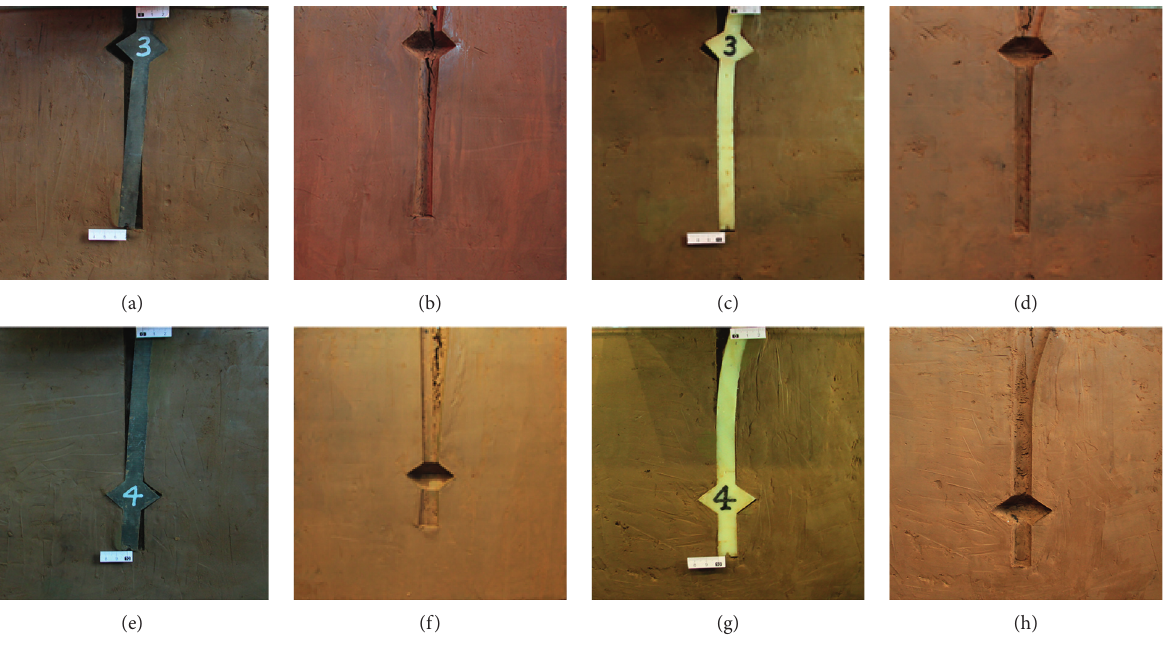
Figure 15: Comparison of soil failure state around different